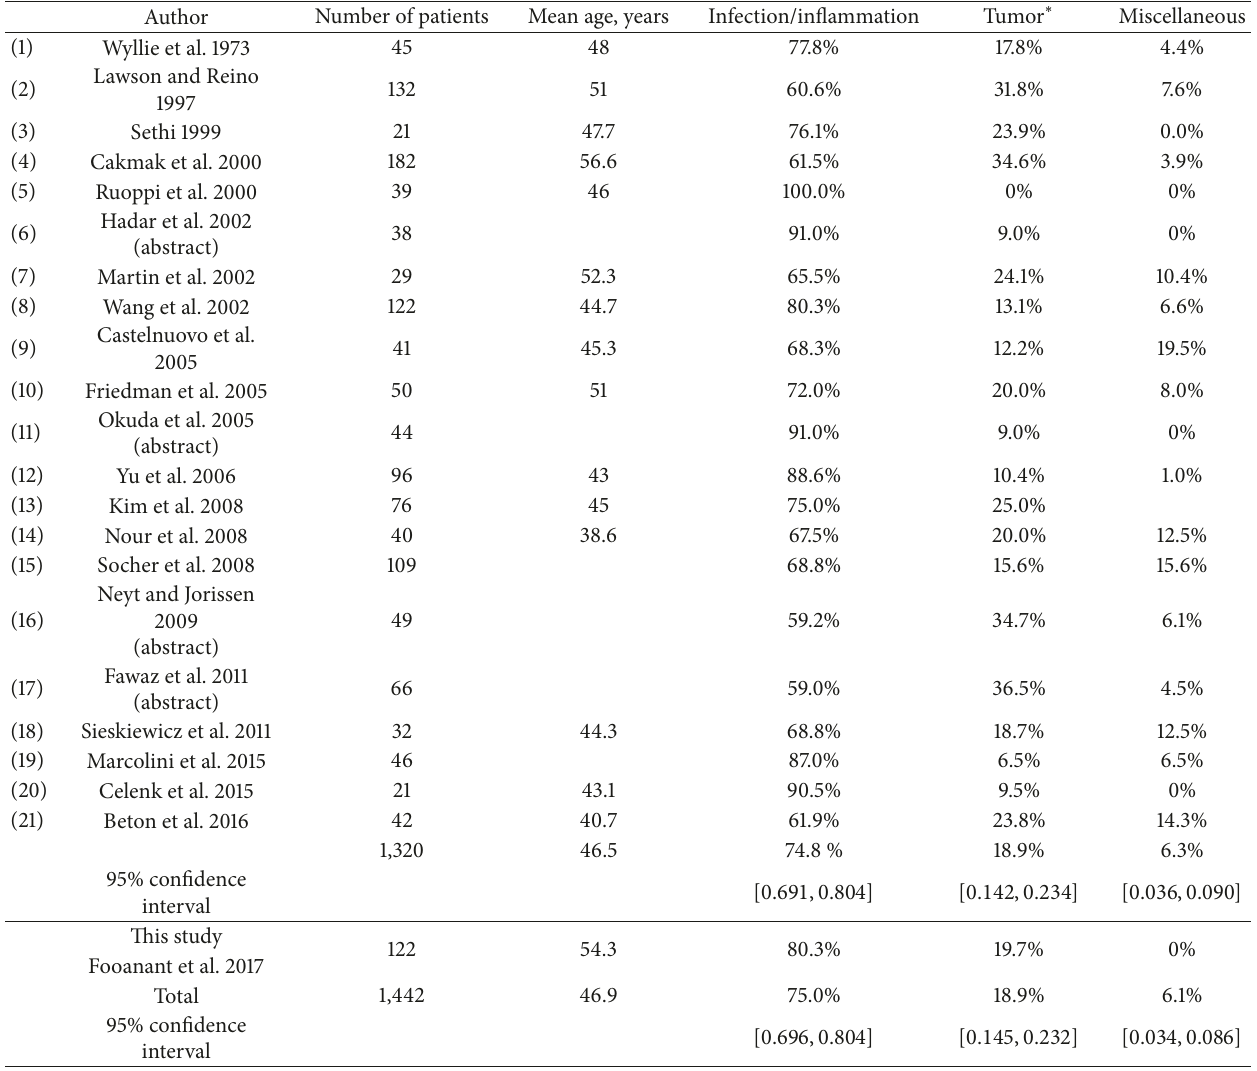
Table 3: Sphenoid sinus lesion